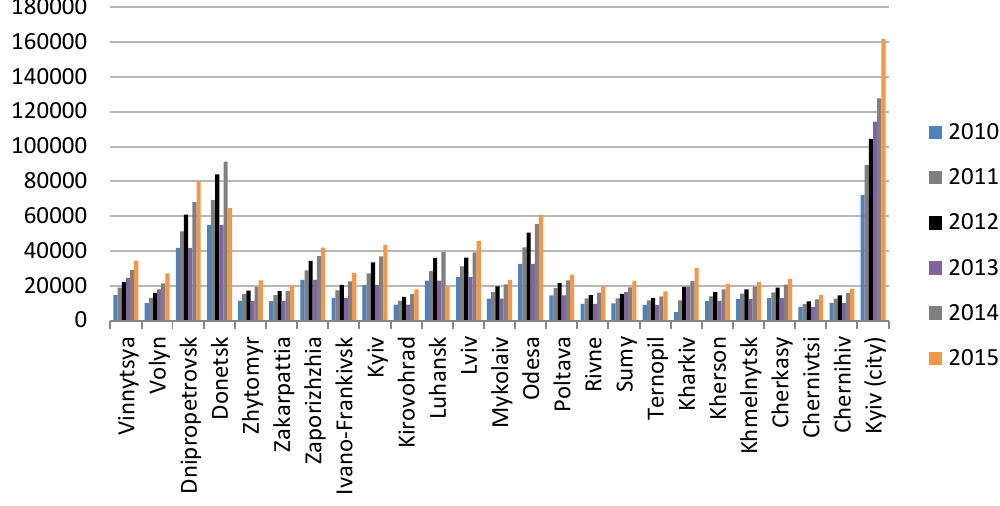
Fig. 6. The retail trade turnover by region in 2010 – 2015, million UAH (based on data of the State Statistics Service of Ukraine)